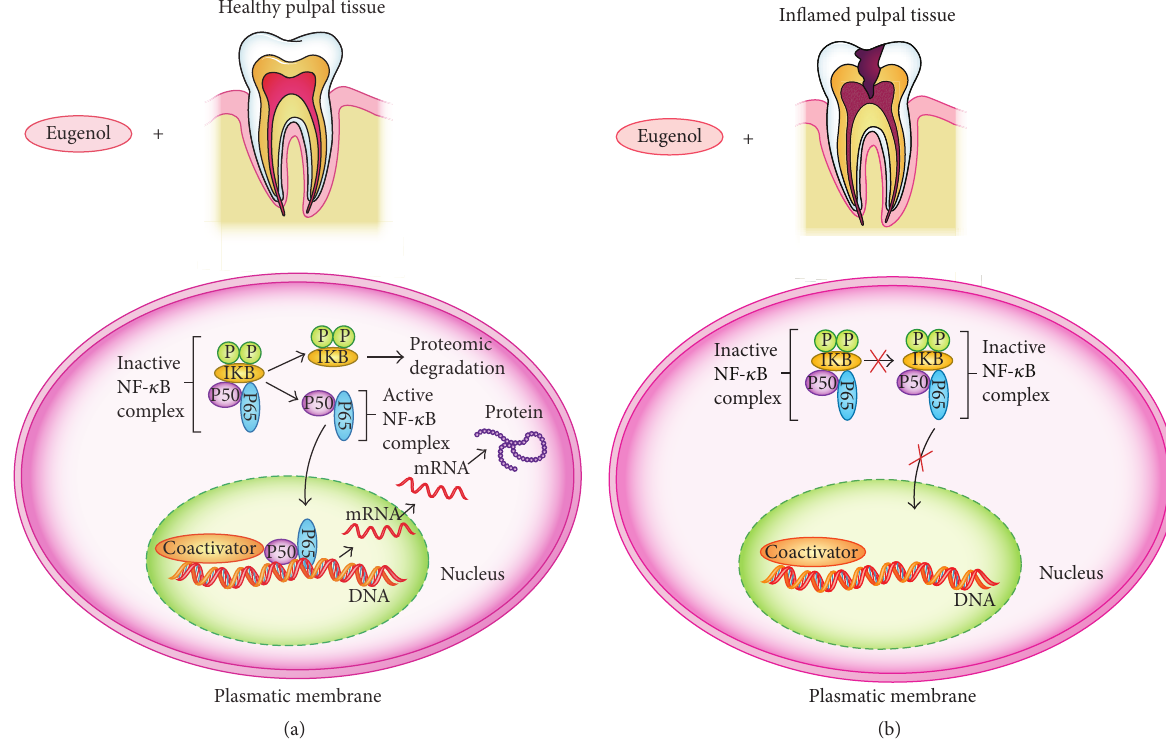
Figure 3: A possible translocation of NF- 𝜅 B for healthy pulp tissue (a) and inflamed pulpal tissue (b). (a) Healthy pulpal tissue. Eugenol allowed interaction with the IKB complex that mediates phosphorylation and degradation of inhibitor protein IKB, in turn activating the NF- 𝜅 B transcription-B factor and translocation of NF- 𝜅 B into the nucleus, where it participates in the activation of other genes involved in both inflammation and apoptosis. (b) Inflamed pulpal tissue. NF- 𝜅 B expression is inhibited when there is preexisting inflammation because they do not carry out IKB phosphorylation inhibitor activities. P-phosphorylation; IKB-complex NF- 𝜅 B inhibitor; P50-homodimer P50; P65-homodimer P65; NF- 𝜅 B-nuclear factor kappa